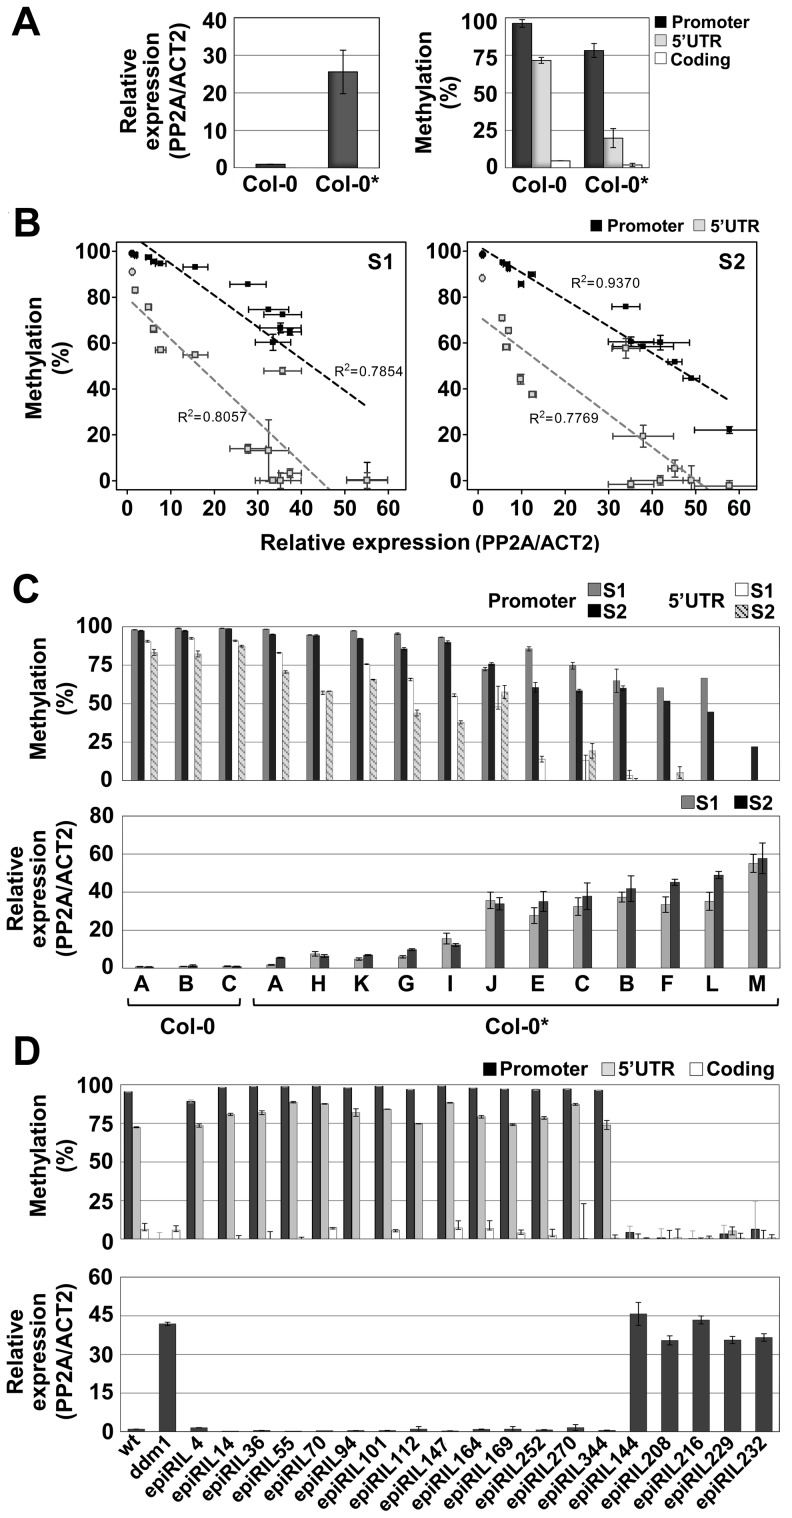
Spontaneous and induced epigenetic variation at QQS.(A) DNA methylation and expression profiles of QQS in seedlings of the Col-0 and Col-0* stocks. (B) and (C) Negative correlation between QQS DNA methylation and expression levels in pooled seedlings of Col-0 and Col-0* (represented by circles and squares in B, respectively) S1 and S2 generation single seed descent lines. (D) DNA methylation and expression levels of QQS in seedlings of ddm1-derived epiRILs. Error bars represent standard deviation observed in three biological replicates (A–D – expression; A – DNA methylation) or two technical replicates (B–D – DNA methylation).